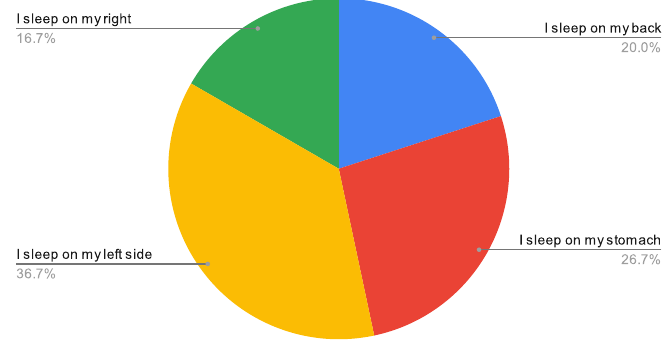
Figure 6. Position of Sleep Before